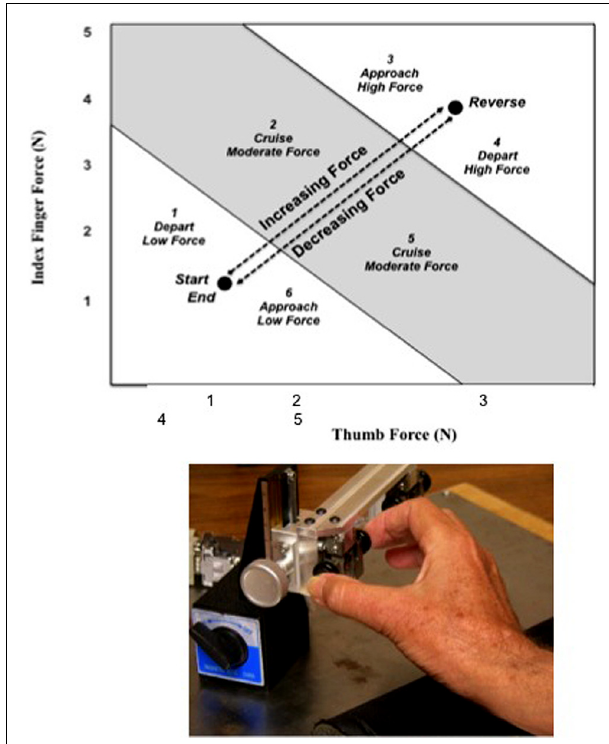
FIGURE 1 | Force tracing template parsed by segment categories. The lower black filled circles indicate both the Start and End circles and the upper black filled circle indicates the Reverse circle.The Start circle is associated with Segment 1 (depart, increasing force); the Reverse circle is associated with both Segment 3 (approach, increasing force) and Segment 4 (depart, decreasing force); and the End circle is associated with Segment 6 (approach, decreasing force). Segment 2 (cruise, increasing force) and Segment 5 (cruise, decreasing force) are not associated with circles.The segment locations and numbers are not visible to the participant, but are developed post-data collection for statistical